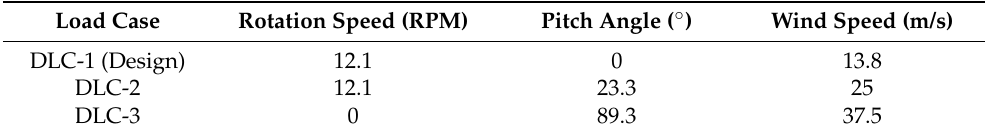
Table 2. Operation parameters in different load